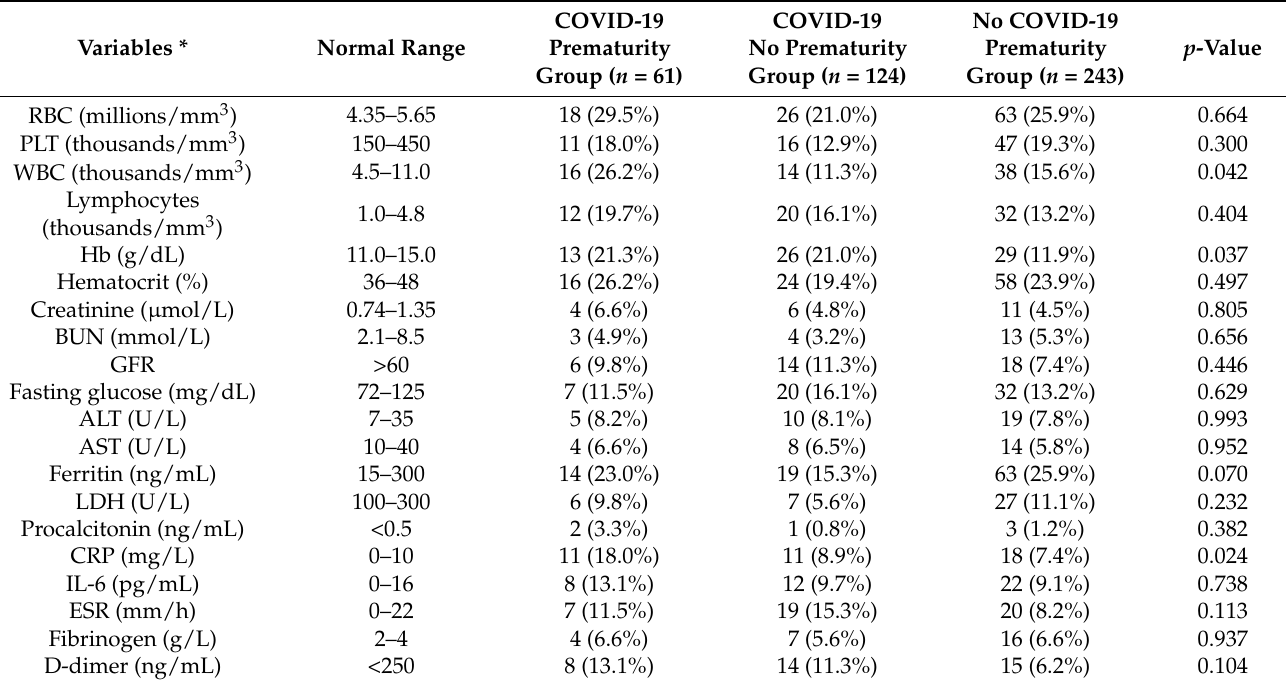
Table 5. Parallel analysis of biological parameters at birth between the three study groups.